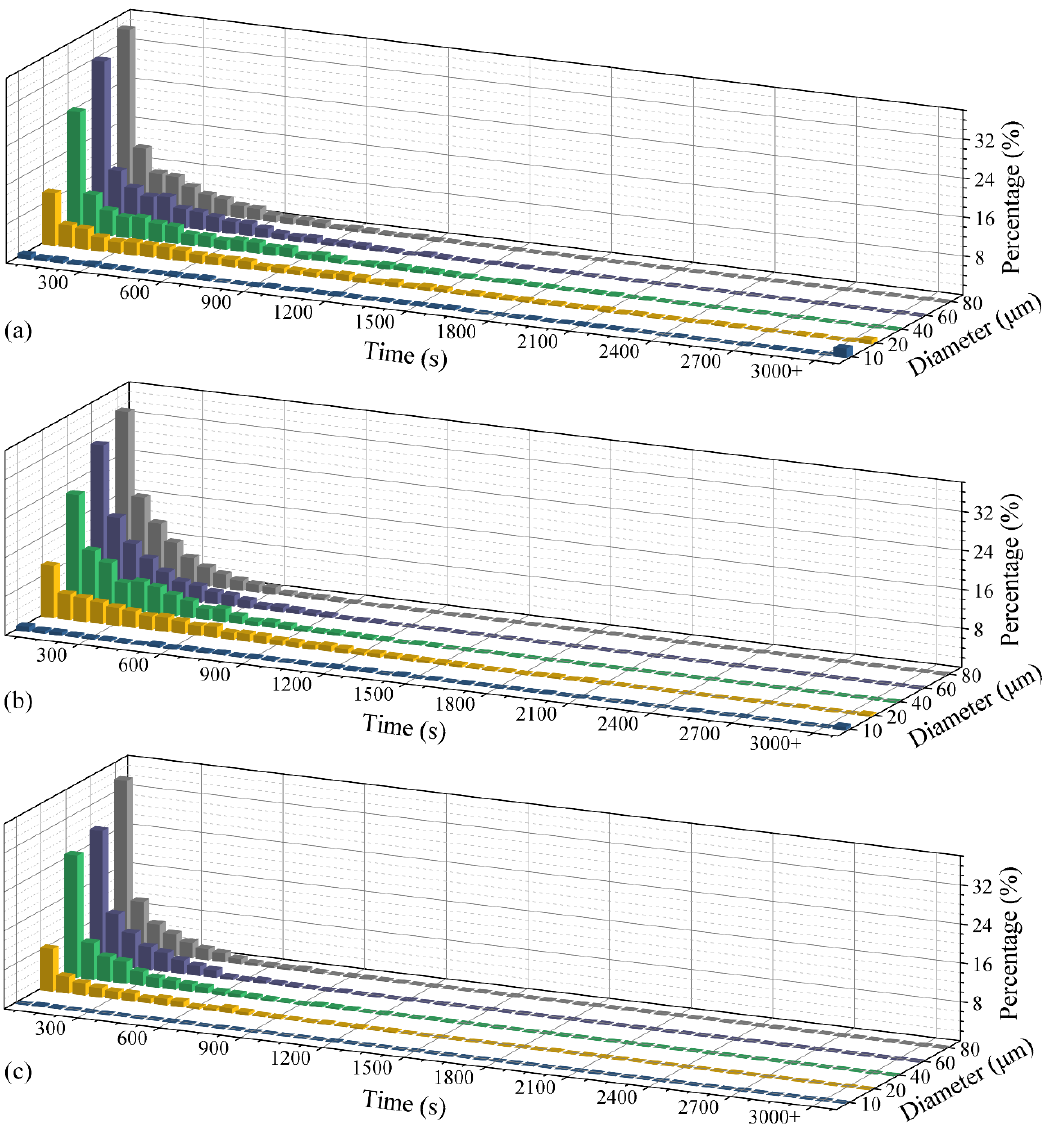
Figure 20. Removal efficiency of inclusions in distributing chamber. ( a ), ( b ) and ( c ) are the results of tundishes A, B and C, respectively.